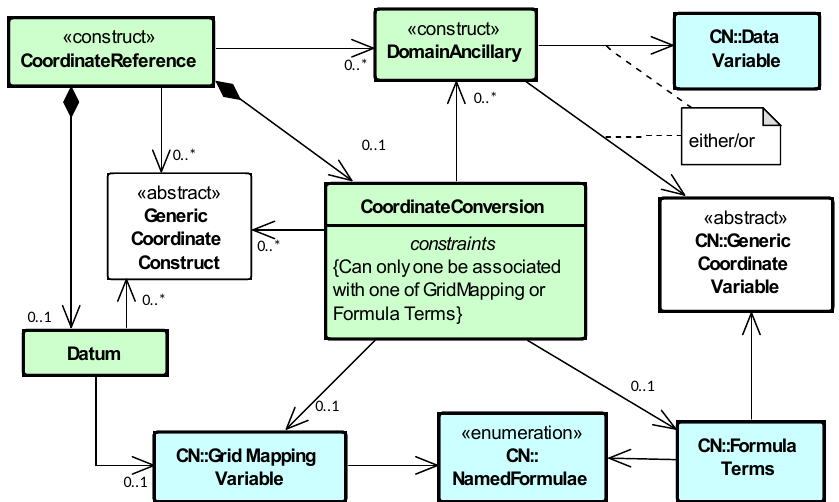
Figure 11. The relationship between coordinate reference and domain ancillary constructs (Sect. 4.4 and 4.5) and CF-netCDF described using UML (Appendix A). A coordinate reference construct is defined either by a grid mapping variable or a formula_terms attribute of a CF-netCDF coordinate variable. The coordinate reference construct is composed of generic coordinate constructs, a datum, and a coordinate conversion formula. The coordinate conversion formula is usually defined by a named formula in the CF conventions. A domain ancillary construct term of a coordinate conversion formula is defined by a CF-netCDF data variable or a CF-netCDF generic coordinate